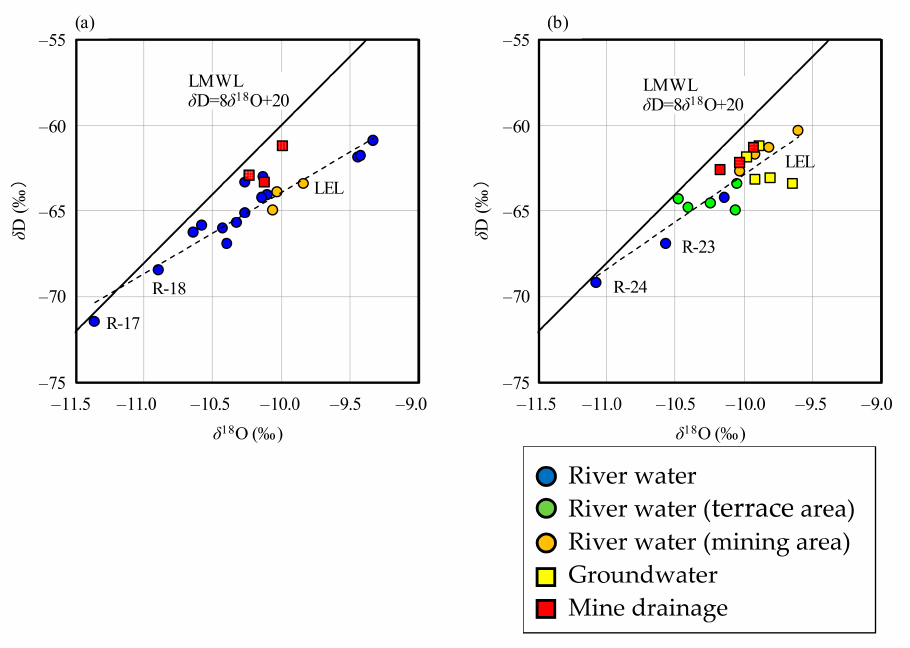
Figure 4. Relationship between δ D and δ 18 O values of water samples, relative to the local meteoric water line (LMWL). ( a ) September 2020; ( b ) December